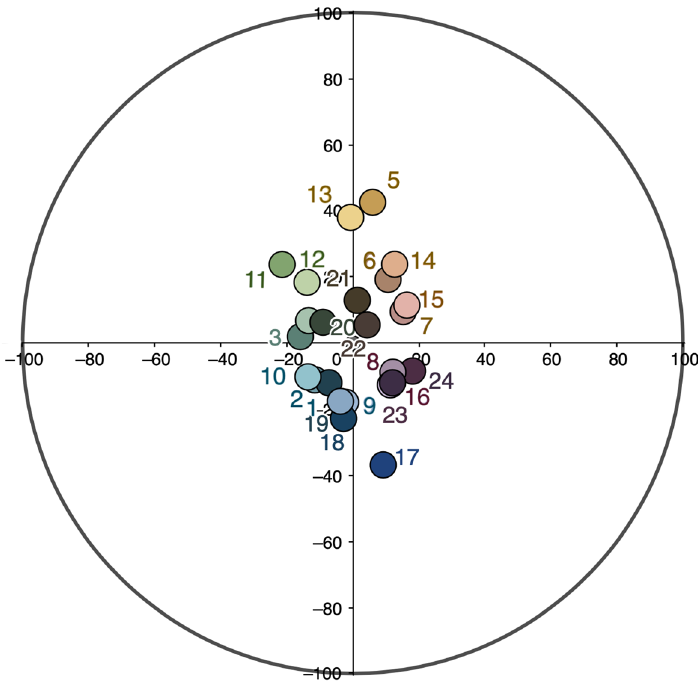
Figure 7. Hue (h ◦ ) and chroma (C) of the environmental background colors from the charts of Figure 7. Hue (h°) and chroma (C) of the environmental background colors from the charts of Sec- tions I to III of the Reference Book ; projection into the CIELCh color circle. Sections I to III of the Reference Book ; projection into the CIELCh color circle.